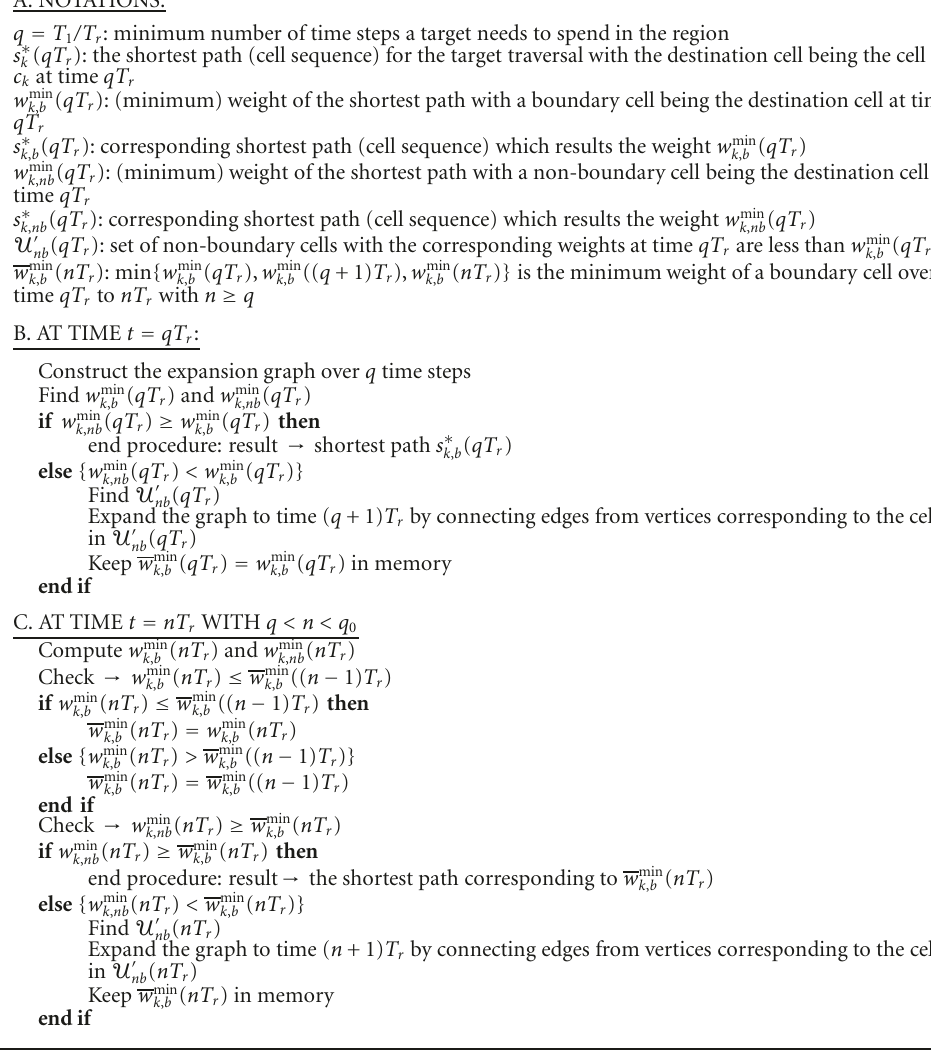
Algorithm 2: (Procedure to find best target